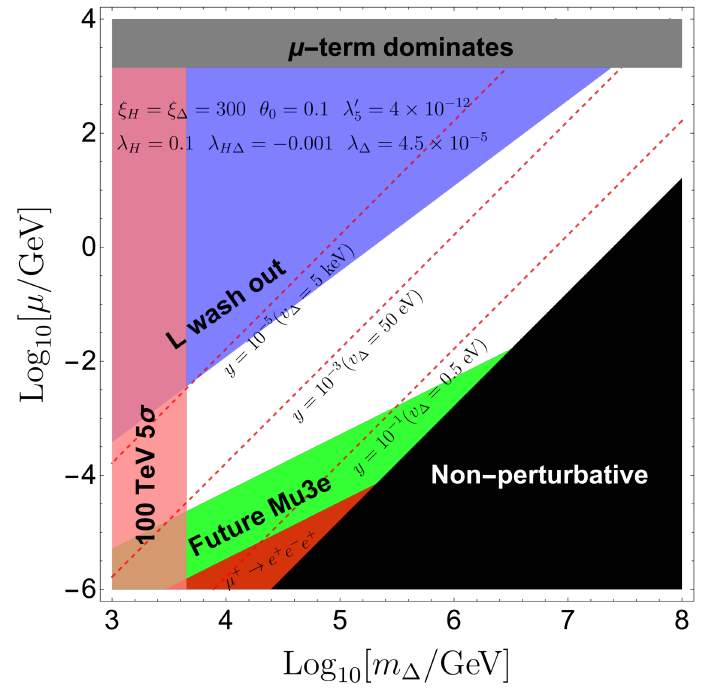
Figure 7 . The allowed region of parameter space is depicted (White), avoiding non-perturbative neutrino Yukawa couplings (Black), cubic term domination of the U(1) (Grey), and lepton asymmetry washout processes (Blue). The red region indicates the current limits from lepton violating processes [111], with green denoting the future Mu3e experimental sensitivity [113]. The future 100 TeV collider constraints are shown in the light red region [109]. We provide dotted red lines to illustrate the corresponding values of the neutrino Yukawa couplings and triplet Higgs VEV within the white allowed